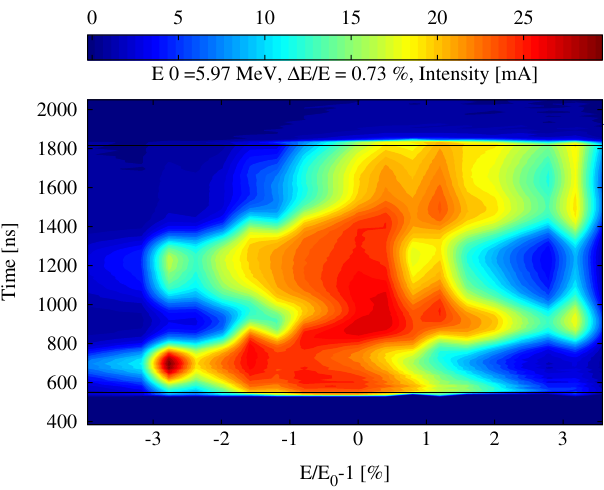
FIG. 17. The correlation of the position stability between the laser and the electron beam for the horizontal axis.